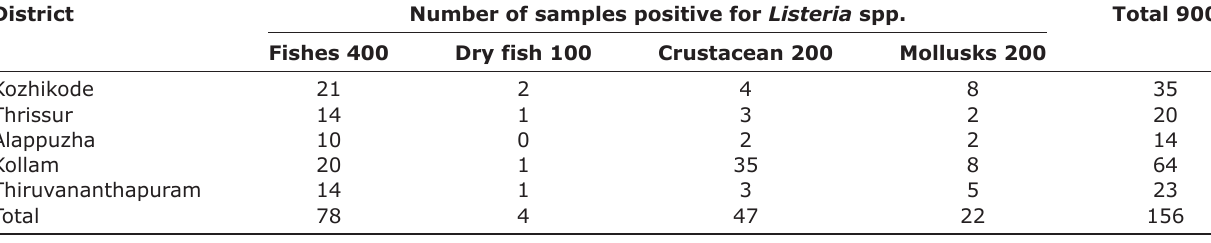
Table-1: District-wise distribution of Listeria innocua in seafoods. District Number of samples positive for Listeria spp.